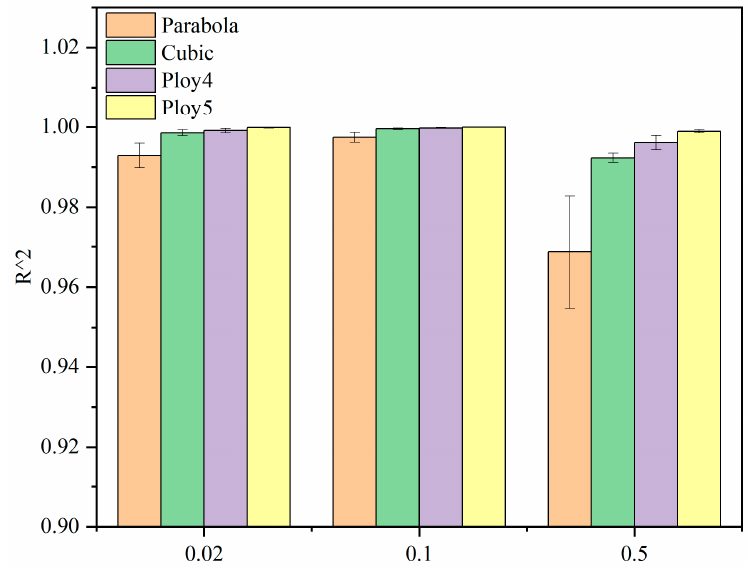
Figure 13. The fitting degree of four hyperelastic models.